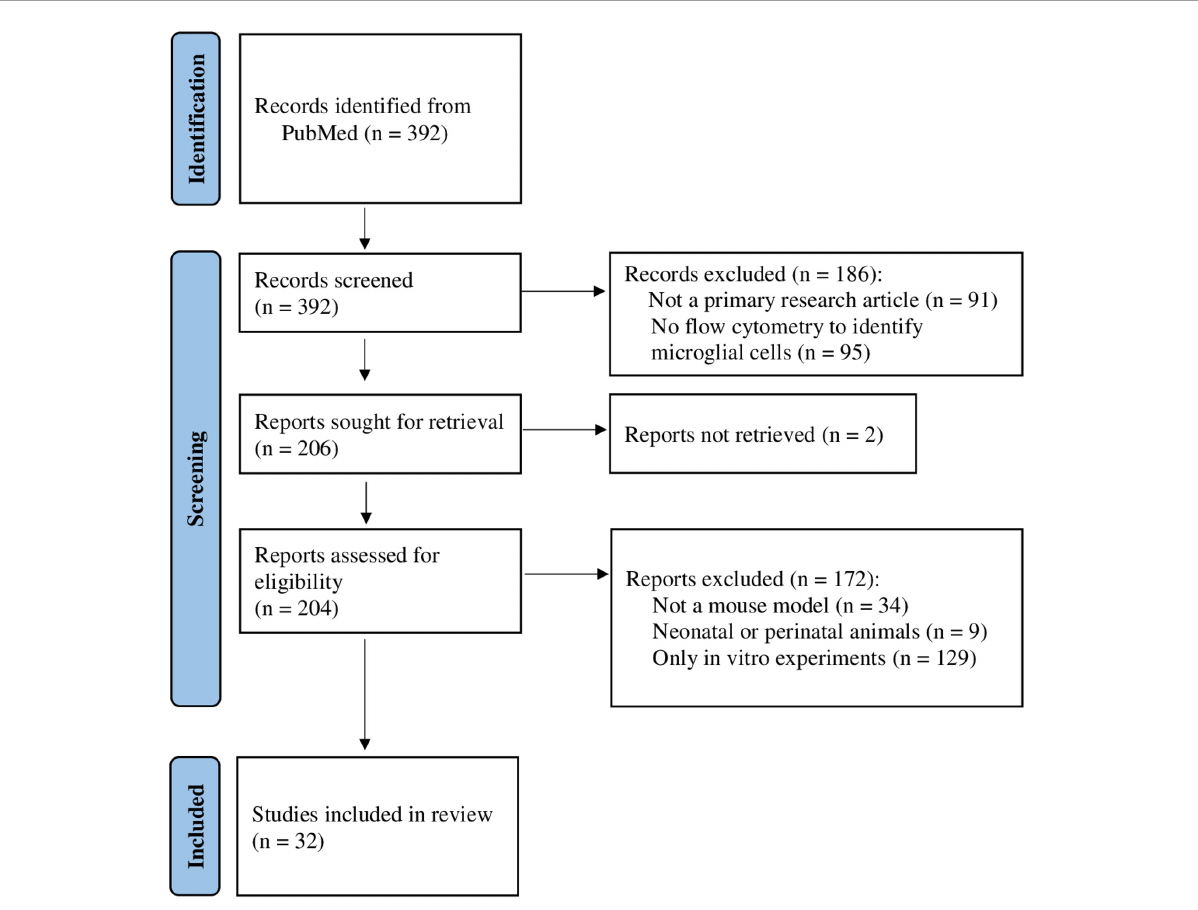
FIGURE2 Flow chart of the study selection process for the identification of studies included in the systematic review. Database search yielded 392 results (2017–2022), and after applying inclusion and exclusion criteria, 32 studies were selected for qualitative